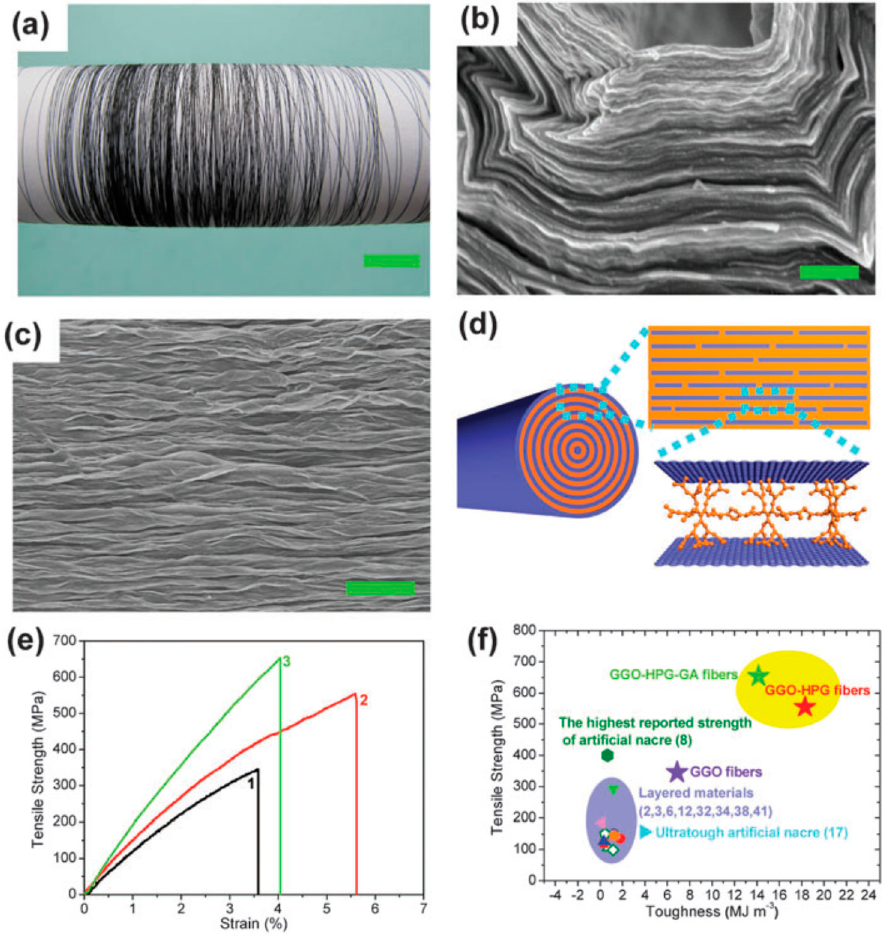
Figure 10. ( a ) Image of a 30 m long GO-HPG gel fiber (scale bar = 10 mm). ( b , c ) SEM images of a cross-section of a GO-HPG gel fiber (( b , c ), scale bars of 250 nm and 3.0 mm, respectively); ( d ) Wet-spinning assembly of complex LCs into nacre-mimetic fibers with hierarchical structures; ( e ) Typical stress-strain curves: (1) GO only; (2) GO-HPG; (3) GO-HPG-GA; ( f ) The strain rate is 10% per minute. Reproduced from [140] with permission from Nature.